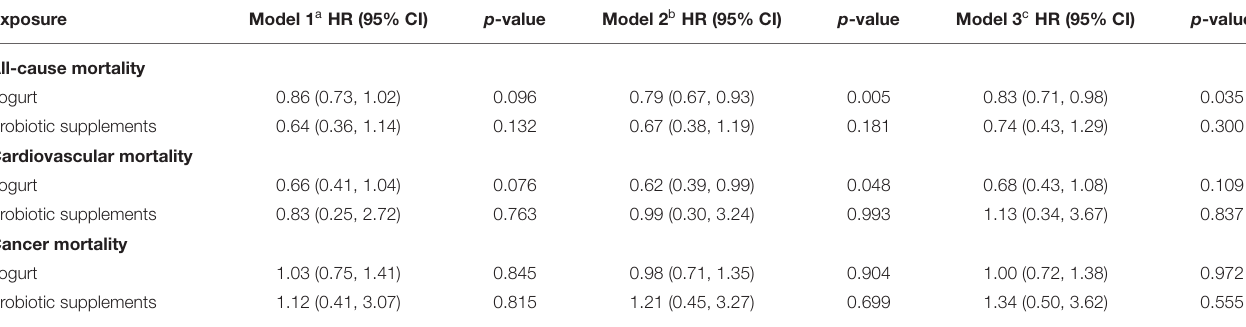
TABLE 2 | Association of probiotic exposure with mortality in 32,625 participants of national health and nutrition examination survey, 1999–2014.